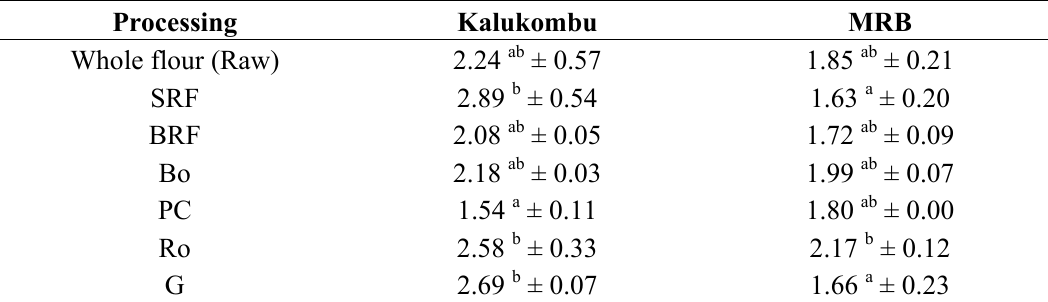
Table 3. Effect of processing on FRAP of two pearl millet varieties.